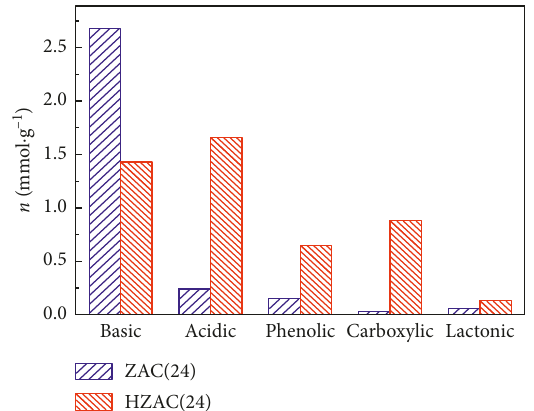
Figure 4: Results of Boehm titration on ZAC(24) and HZAC(24)